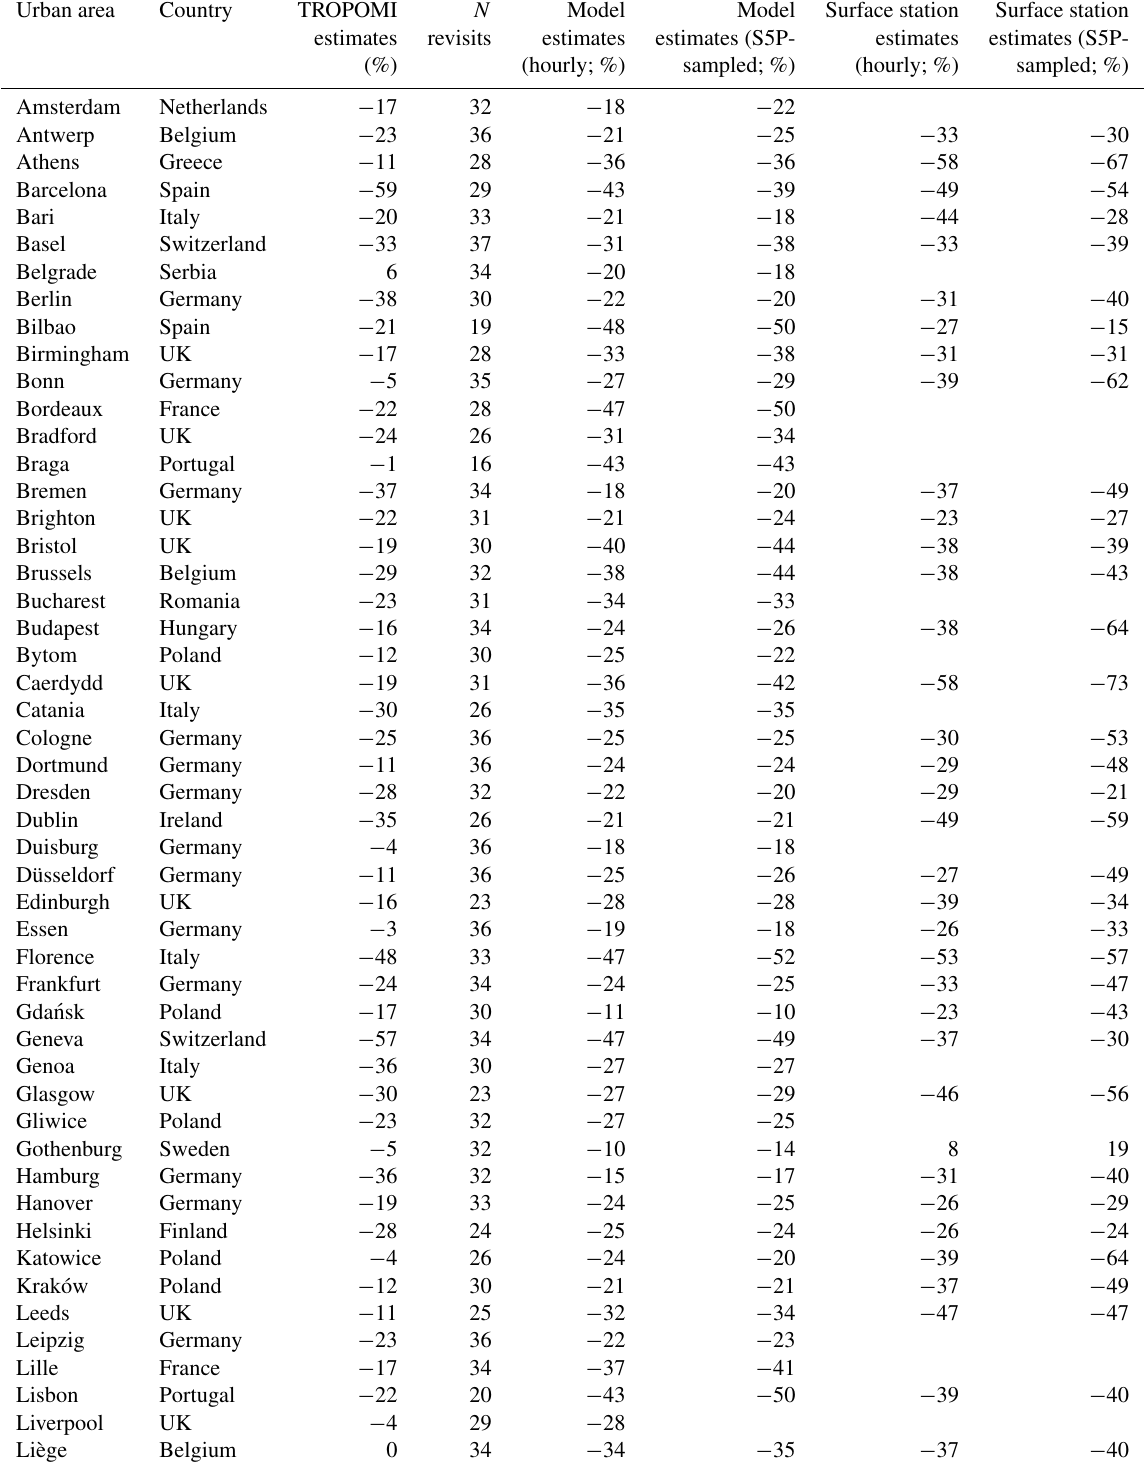
Table B1. Lockdown-induced NO 2 change estimates for each European urban area considered in this study. Urban